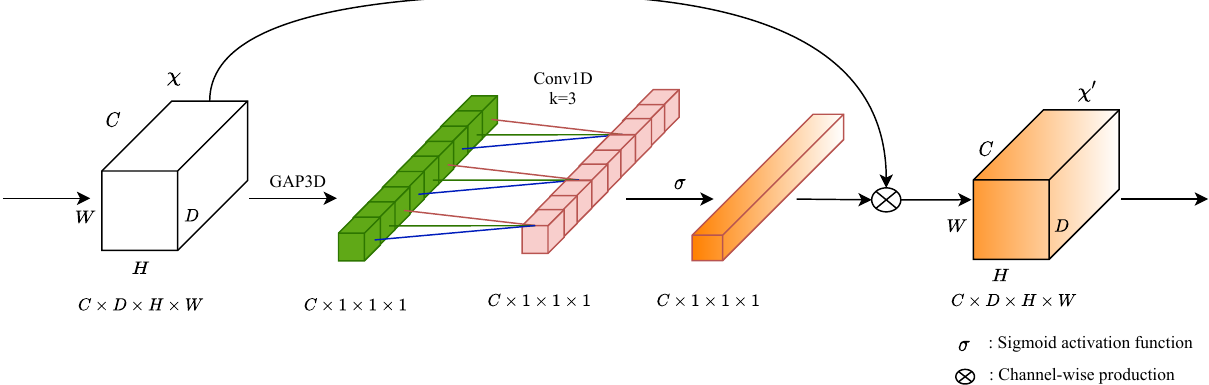
Figure 3. The architecture of 3D ECA blocks. We build the 3D ECA blocks for exploring channel-wise attention during cost volume regularization. In the original paper, the kernel size k of Conv1D is adaptively determined according to channel dimension C . In the 3D part of PSMNet, we set all kernel sizes k to 3 in terms of the relatively small feature